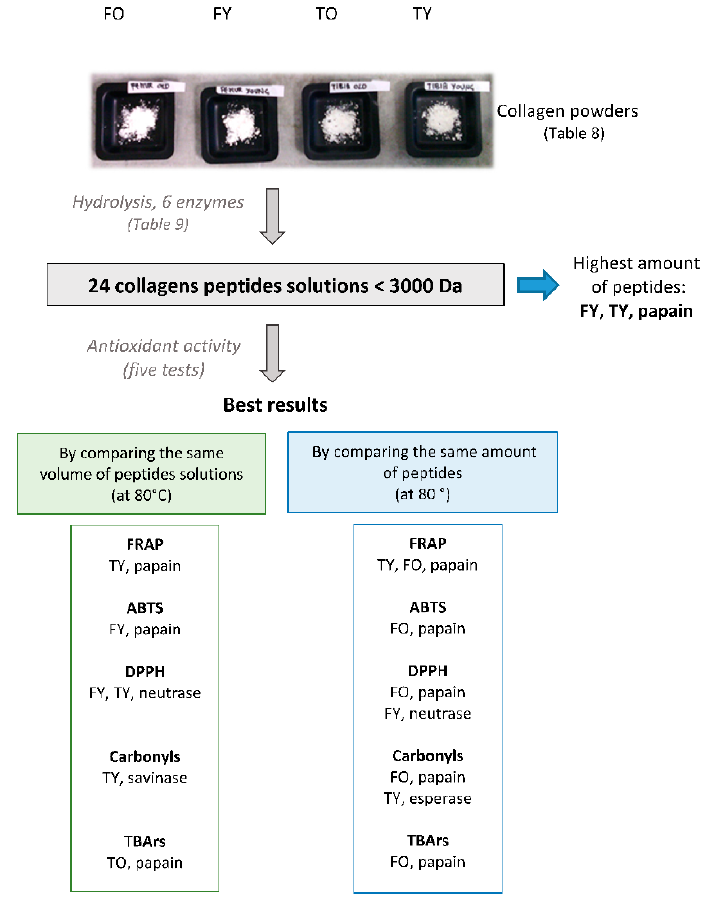
Figure 10. Overview of the antioxidant activity of bovine bone collagen peptides (at 80 °C) by considering bones of different ages and anatomies (femur old, 10 and; femur young, 4.5 years; tibia old, 10 years; tibia young, 4.5 years), and six enzymes (alcalase, collagenase, esperase, neutrase, papain, savinase).